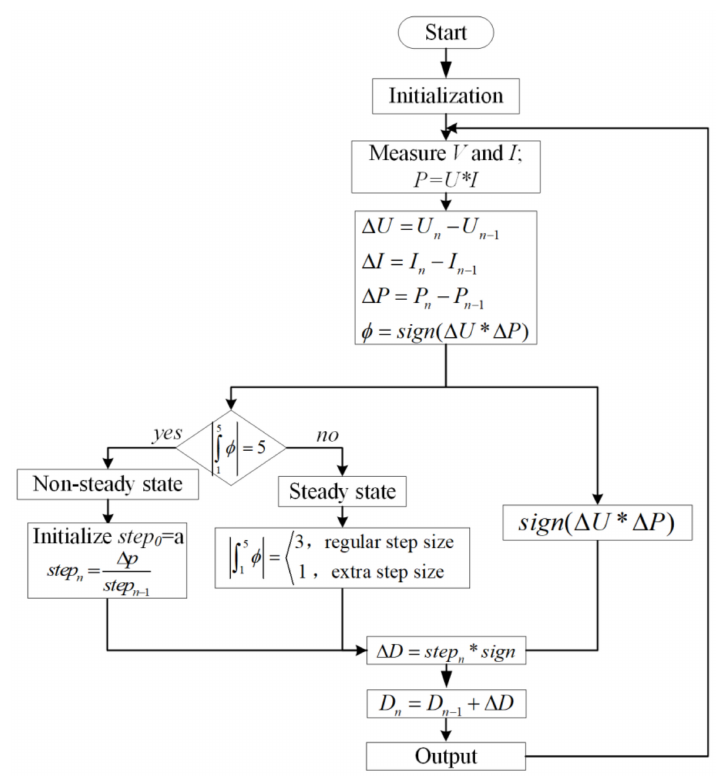
Figure 16. The complete flowchart of the modified